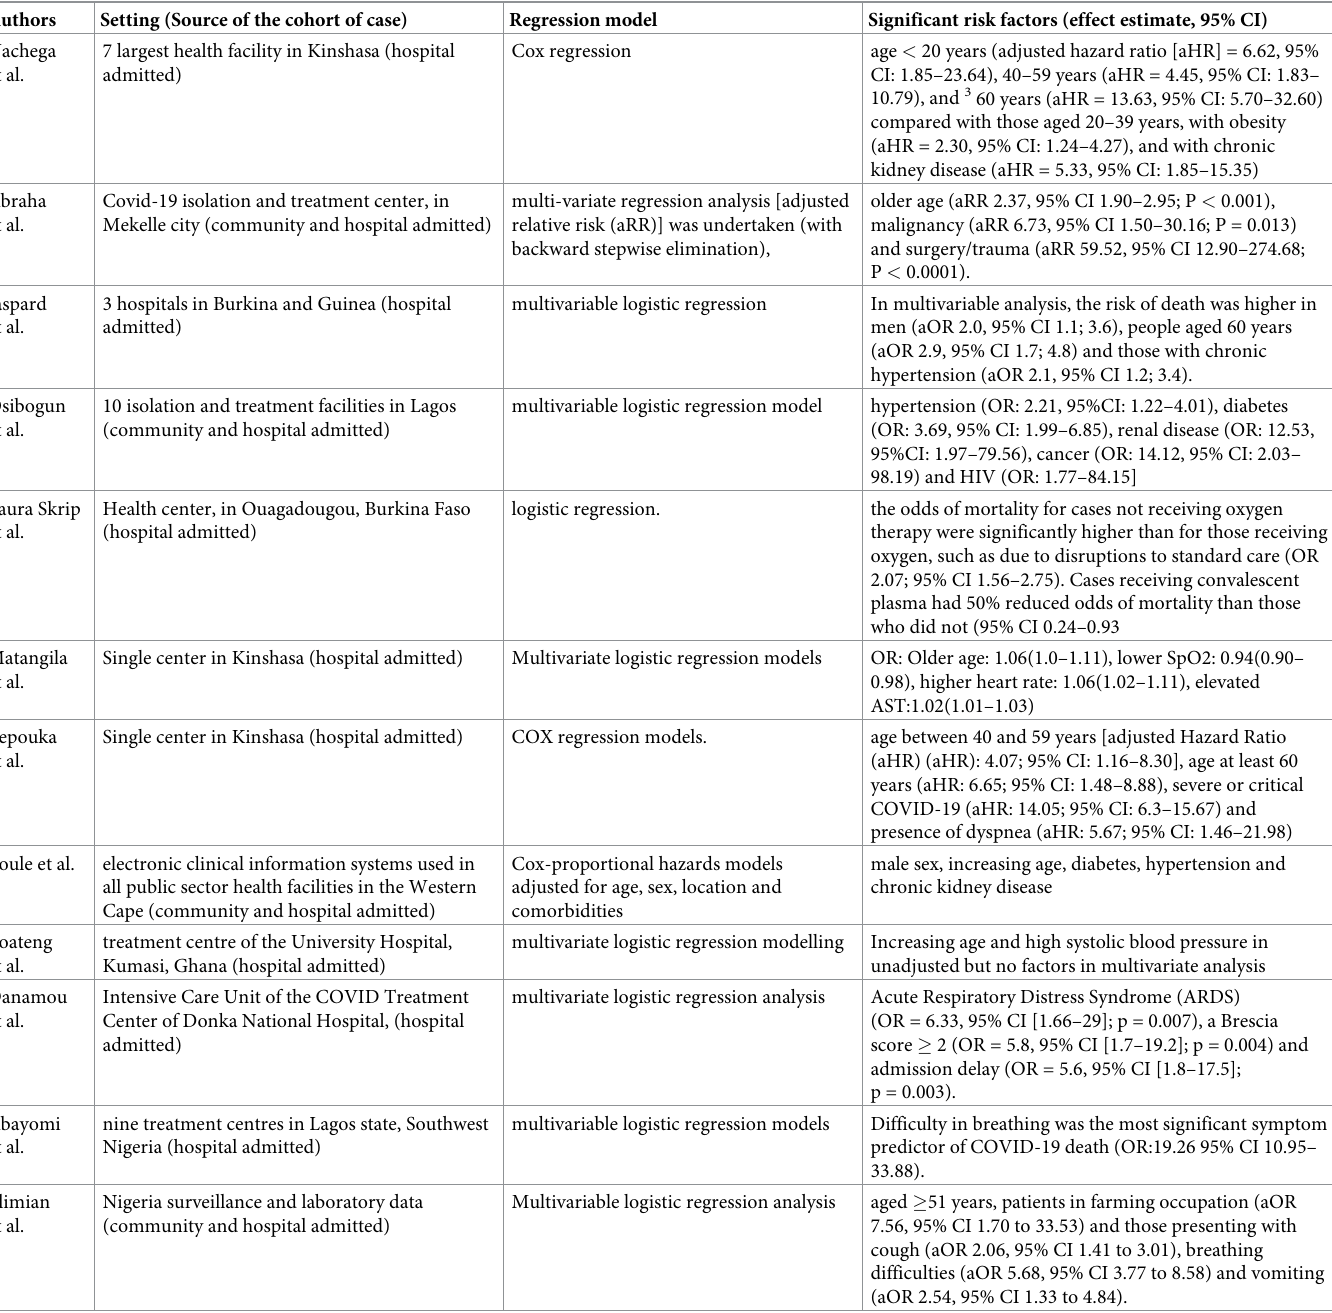
Table 2. Risk factors for increased risk of mortality in studies using regression